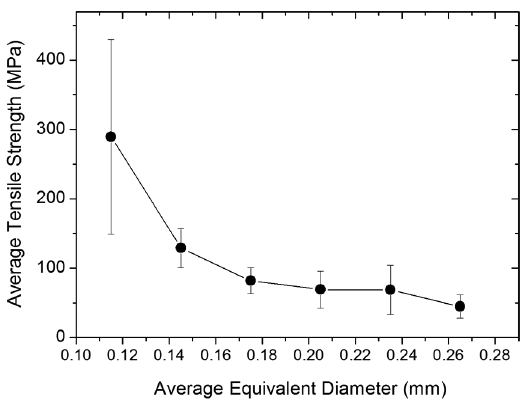
Figure 8. Variation of the PALF Weibull average strength with the corresponding fiber equivalent diameter for each interval in Figure